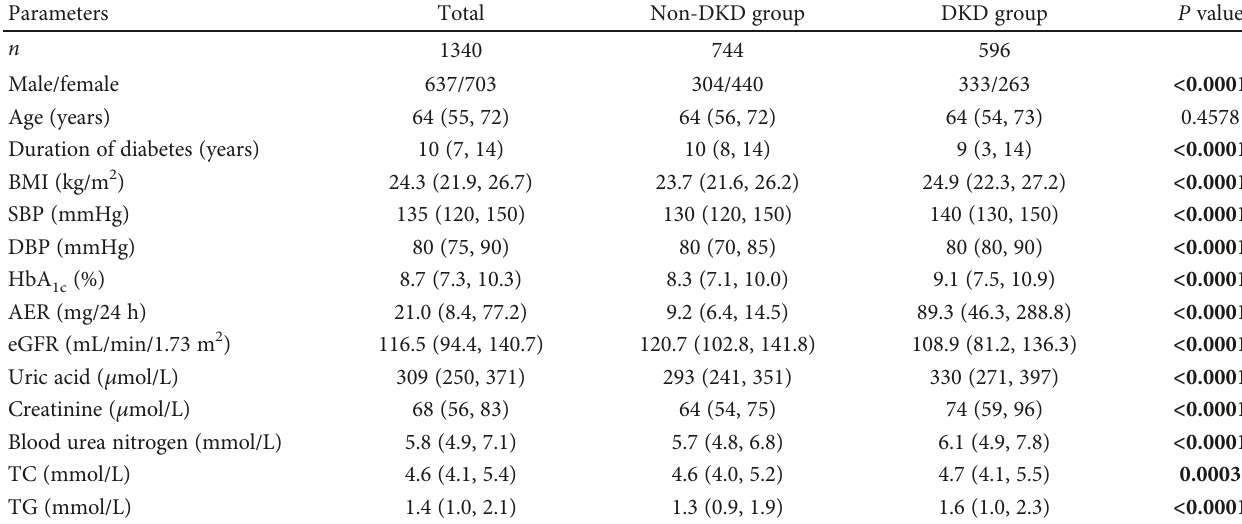
Table 2: Clinical characteristics of the study samples.